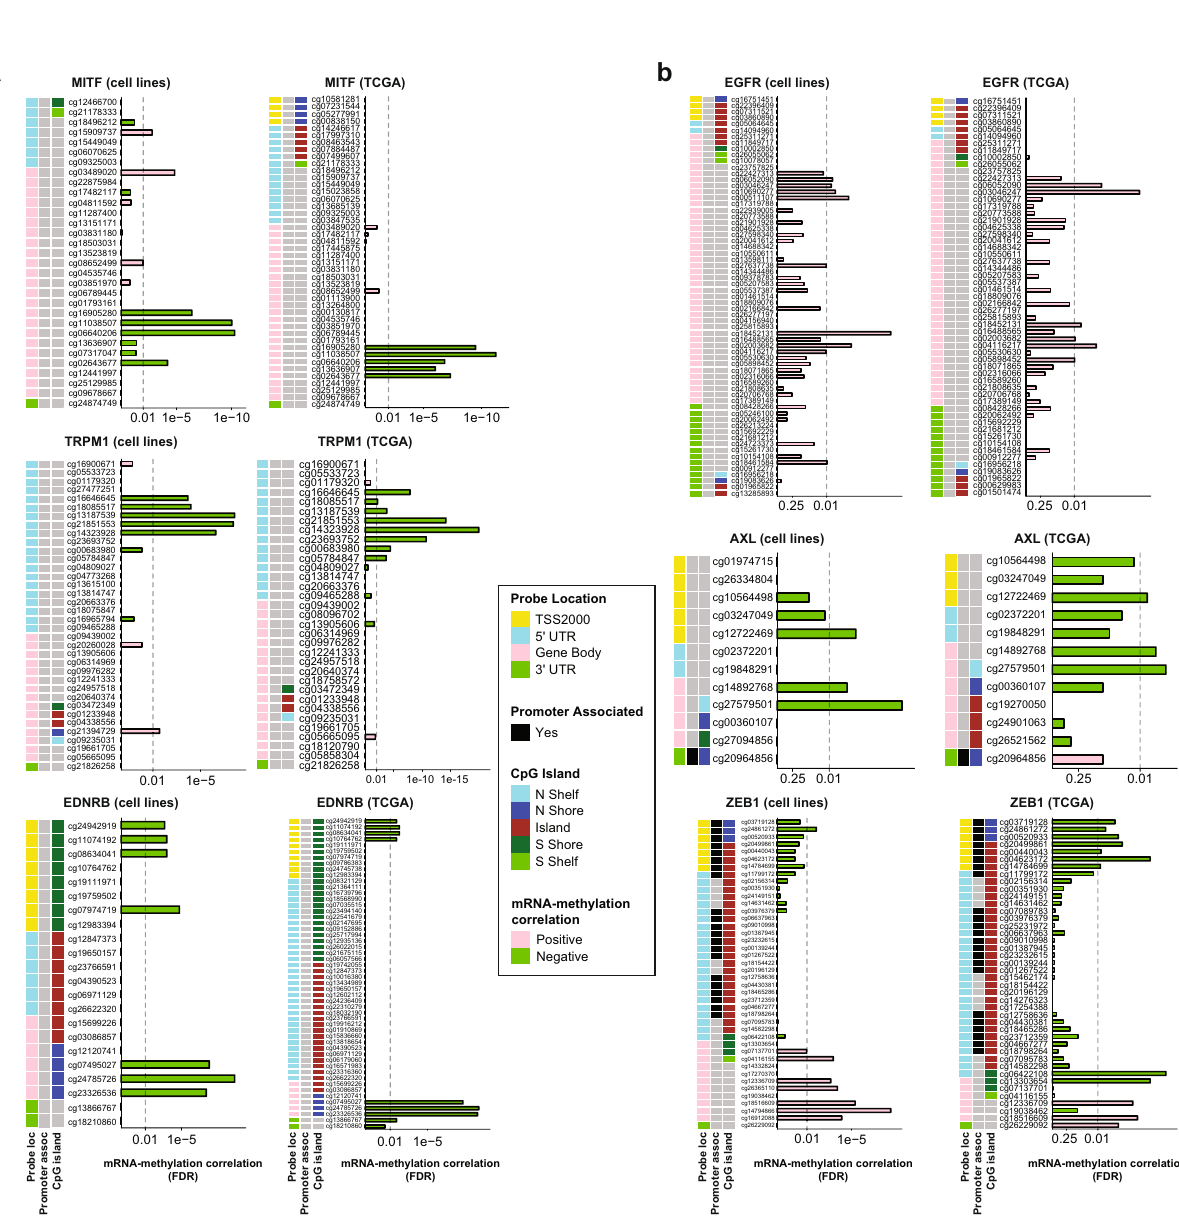
Fig. 4 DNA methylation demonstrates site- and gene-speci fi c associations with MEL and MES gene expression. a , b Overview of statistically signi fi cant DNA methylation events for ( a ) 3 MEL genes and ( b ) 3 MES genes contrasting the observed exclusively negative (green bars), exclusively positive (pink bars), and mixed patterns of correlation between individual methylation probes and expression of the indicated gene. FDR-corrected two-sided Spearman correlation p values are shown. For each gene, DNA methylation in MDACC cell lines is shown at the left, and in TCGA melanoma samples at the right; note that due to processing pipelines used, the available datasets report overlapping but non-identical probesets per